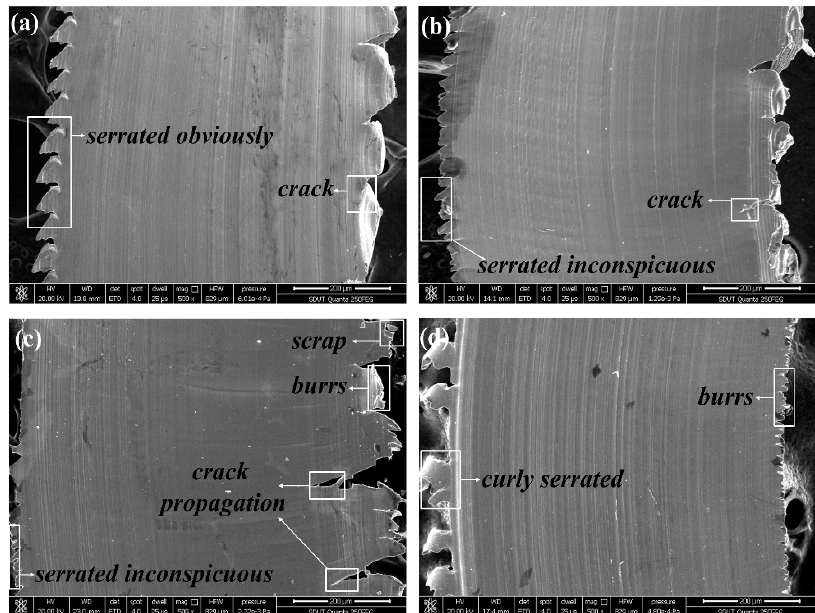
Figure 2. Micrographs of chip surfaces flowing from rake face at v c = 440 m/min, f z = 0.04 mm/z, a p = 0.4 mm, and a e = 4 mm, ( a ) TiN/TiCN/TiAlN multi-coating, ( b ) AlTiN coating, ( c ) TiAlN + TiN composite coating, and ( d ) TiCN + NbC composite coating.